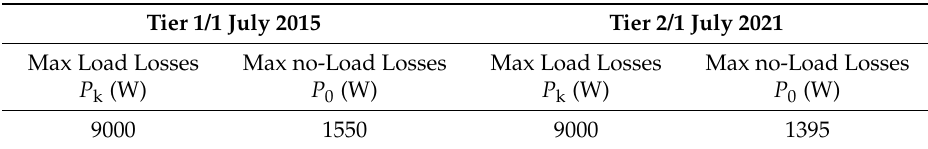
Table 3. Limits Tier 1 and Tier 2 for dry transformers (1 MVA, V 1 ≤ 24 kV, V 2 ≤ 1.1 kV)